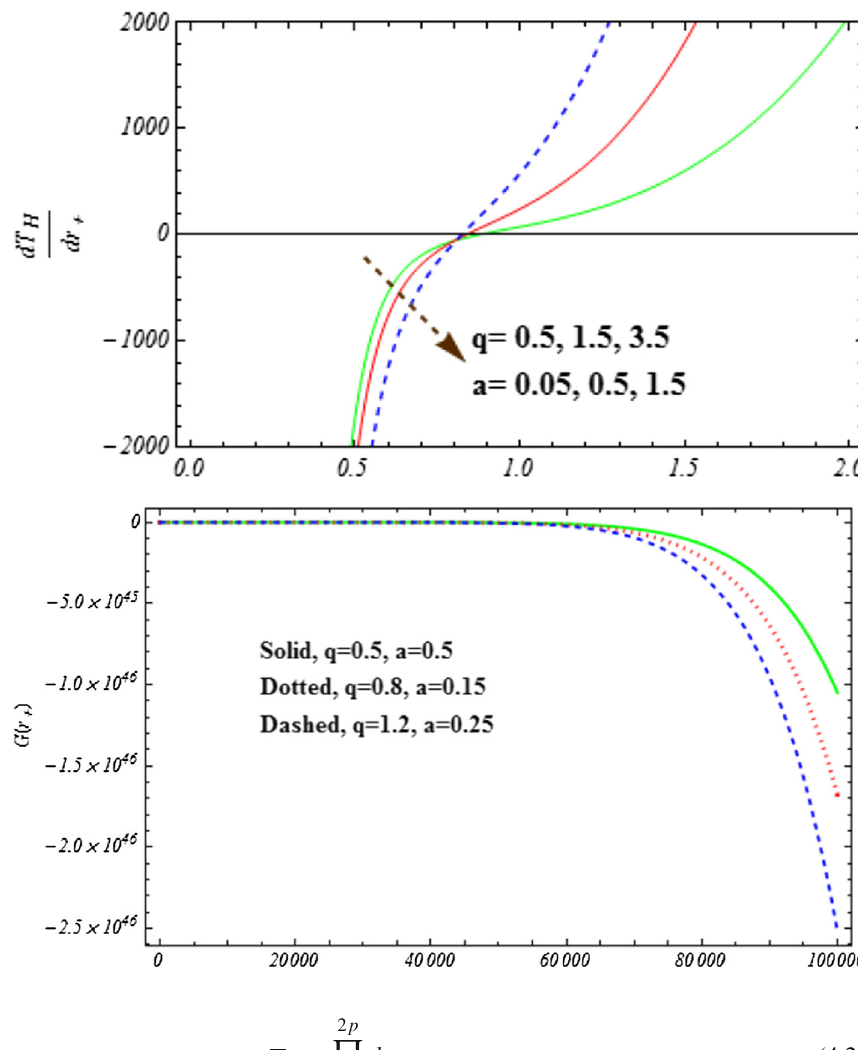
Fig. 10 The plot of dT H (Eq. dr + (3.12)) vs r + for fixed values of l = 1, δ d , 2 n − 1 = 100, ω = − 0 . 7, (cid:13) = 1, n = 3, q d − 2